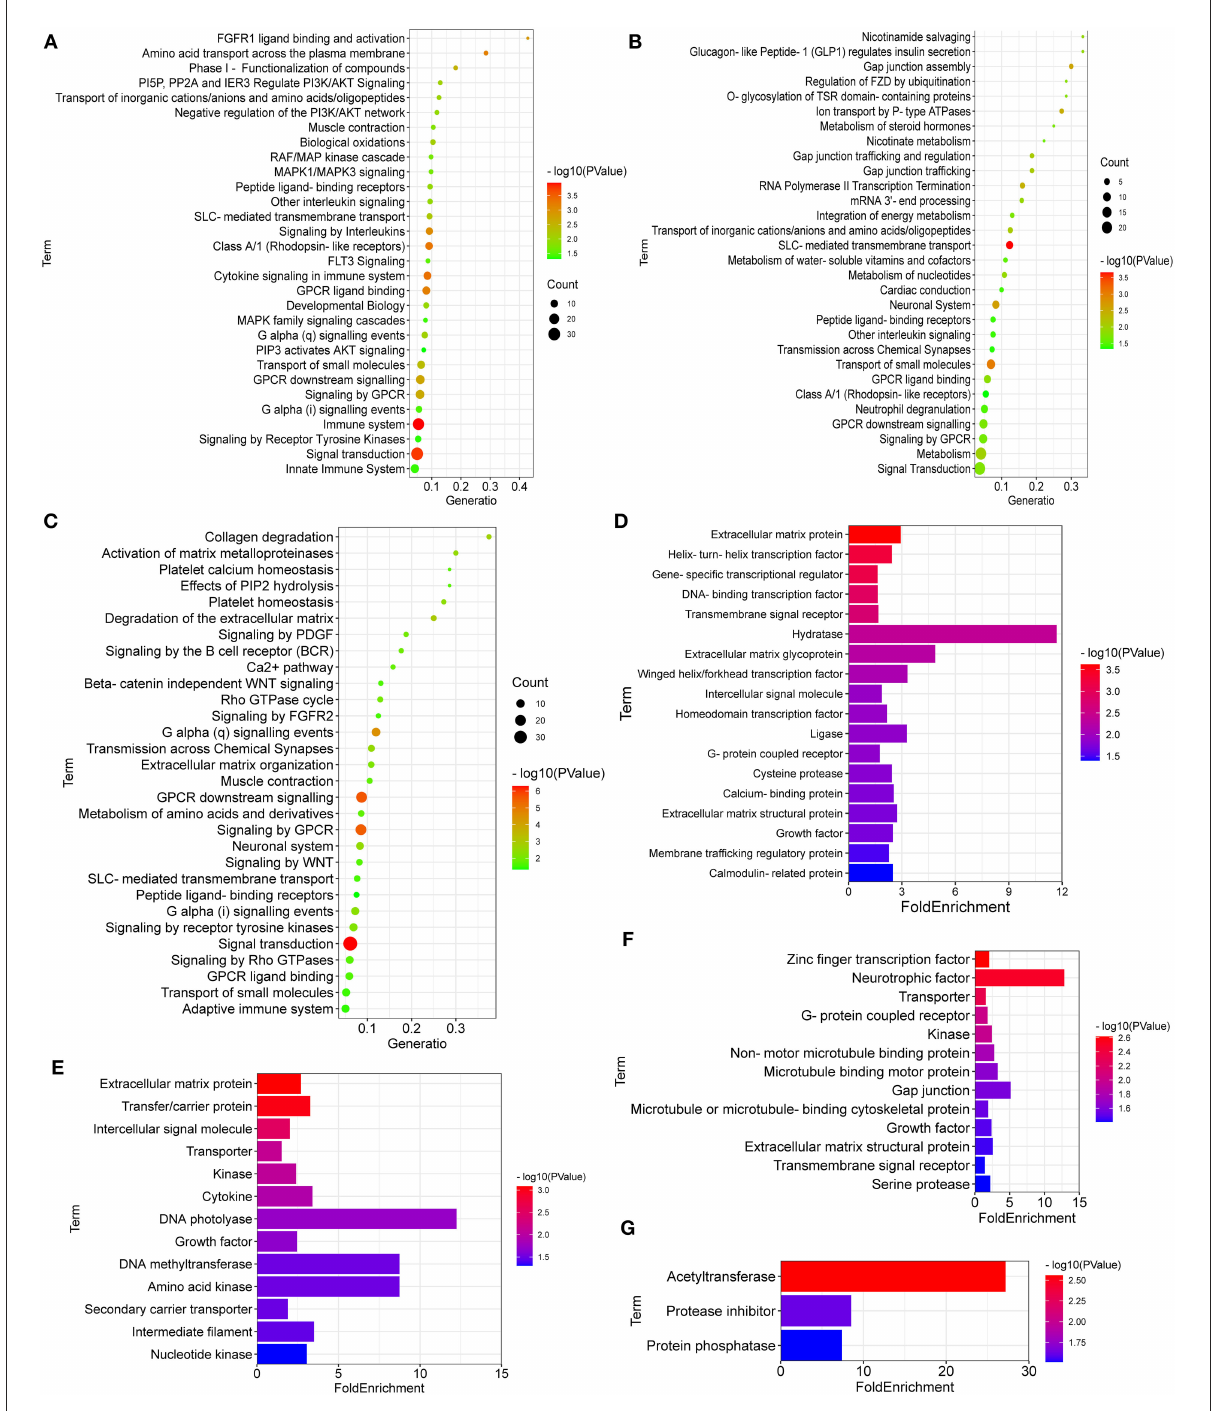
FIGURE4 Reactome enrichment and protein class for the breed-special DEGs. (A–F) showed Reactome enrichment and protein class for the breed-special DEGs in the hearts of SG, TB, and DRW chickens. (G) showed protein class of the common DEGs among the three chicken breeds.